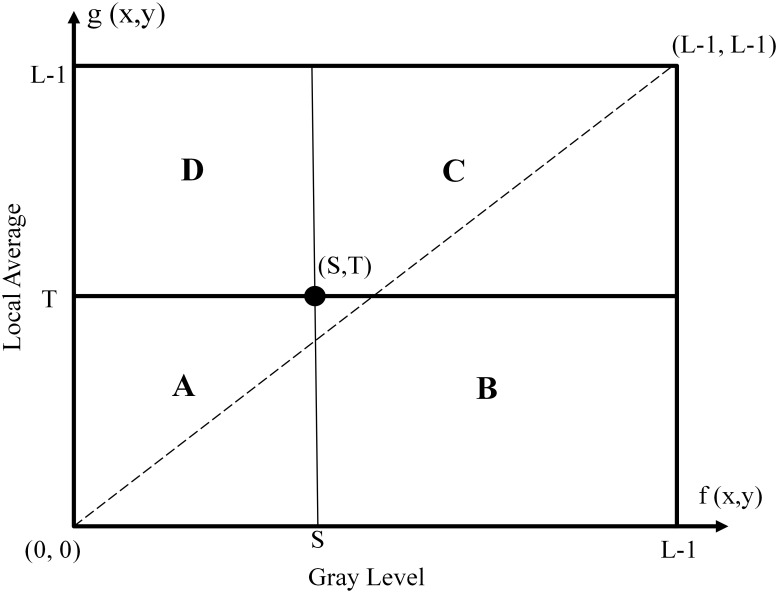
2D histogram top view.